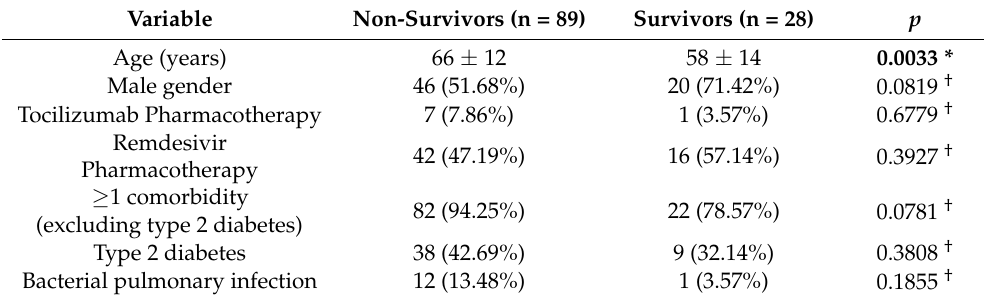
Table 1. Comparison of demographic and clinical characteristics between survivors and non-survivors.